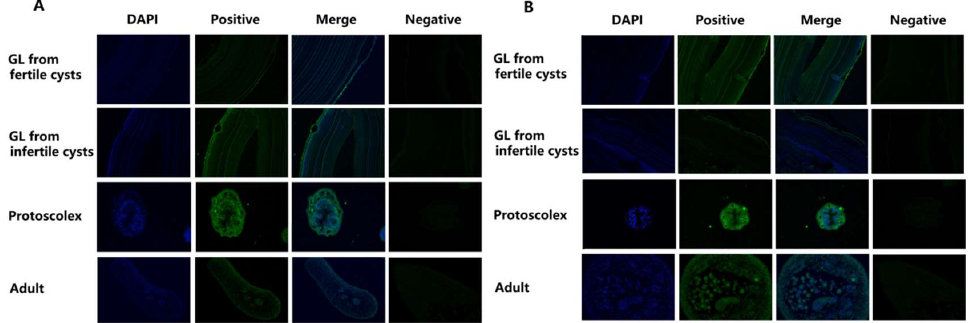
Figure 4. Immunohistochemical localisation of Eg-Fis1 and Eg-PDCD6 in different life cycle stages of E. granulosus . ( A ) Immunohistochemical localisation of Eg-Fis1; ( B ) Immunohistochemical localisation of Eg-PDCD6. Images of PSCs are magnified at 400 × , and cyst walls and adult worms are magnified at 200 × . The nucleus was stained with DAPI in blue color and cells marked with green fluorescence were confirmed as positive cells.